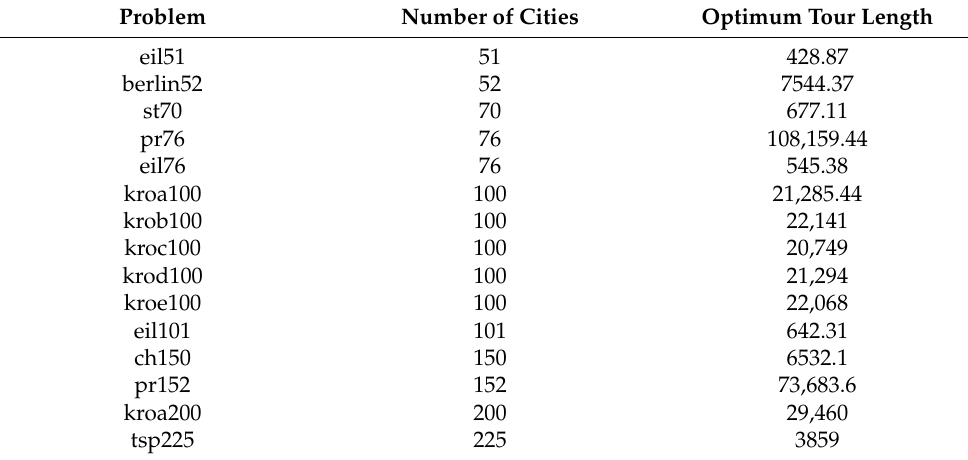
Table 1. Number of cities and optimum tour lengths of the problems.